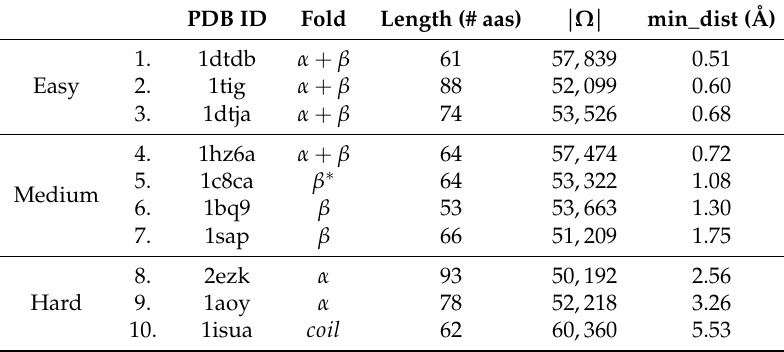
Table 1. Column 2 shows the PDB ID of a known native structure for each test case. Columns 3 and 4 show the fold (* indicates native structures with a predominant β fold and a short helix) and the length (number of amino acids), respectively. Column 5 shows the size of the decoy set Ω generated via Rosetta, and column 6 shows the lowest lRMSD from the known native structure over the decoy